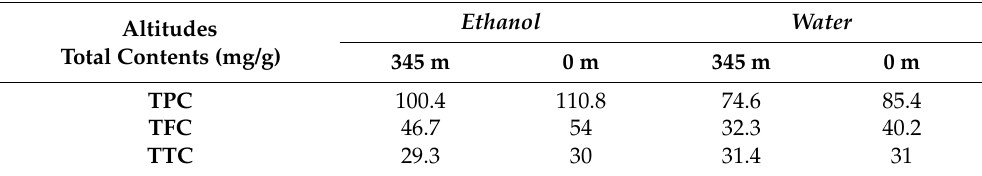
Table 3. Quantification of total phenolic (TPC), flavonoids (TFC), and tannin (TTC) contents in different